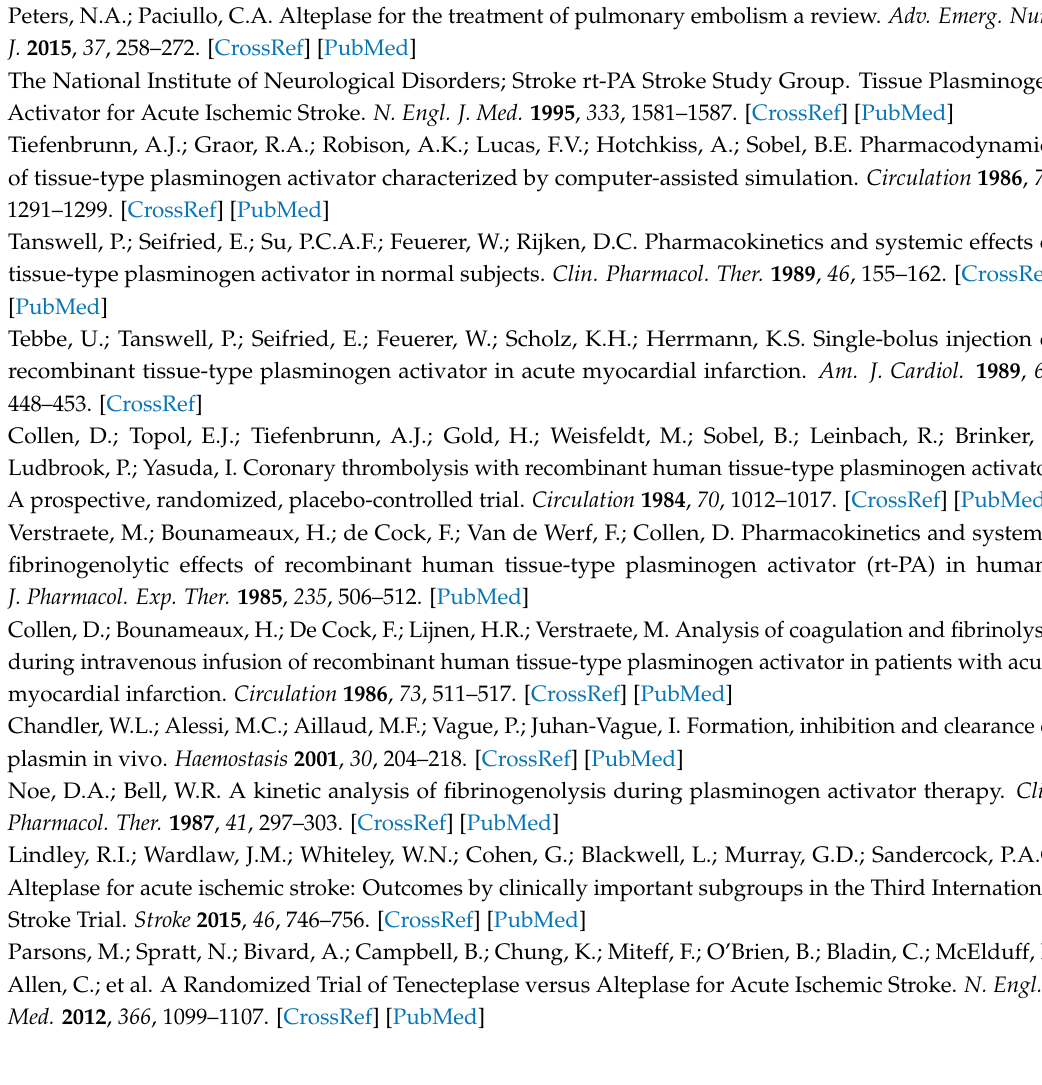
Figure S1: Illustration of space and time discretisation, Figure S2: Data presented in Tienfenbrunn et al. with 25 mg of tPA infused over 7 h, Figure S3: Data presented in Tienfenbrunn et al. with 60 mg of tPA infused over 90 min, Figure S4: Data presented in Collen et al. with 0.75 mg/kg of tPA over 90 min, Figure S5: Data presented in Tanswell et al. with tPA dose of 0.25 mg/kg over 30 min, Figure S6: Data presented in Tanswell et al. with tPA dose of 0.5 mg/kg over 30 min, Figure S7: Data presented in Tebbe et al with a single bolus of 50 mg of tPA over 2 min, Table S1: Summary of reactions between plasma proteins in the systemic PKPD model, Table S2: Additional parameter values for the new compartment model, Table S3: Summary of grid test